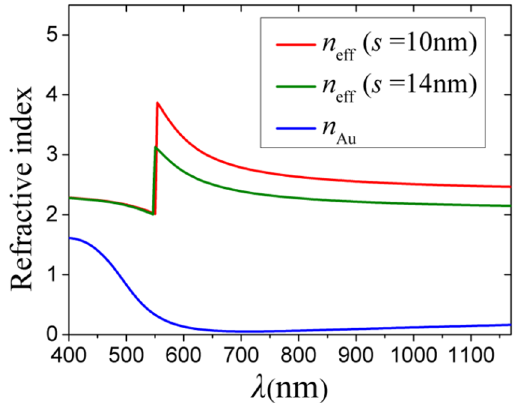
Figure 4. Effective refractive indices (n eff ) of fundamental SPP mode of a TiO 2 -Au-air-Au-TiO 2 multilayer plasmonic waveguide with air spacing, s = 10 (red) and 14 (green) nm. The real parts of the refractive index of Au (n Au ) 37 is also plotted as a blue